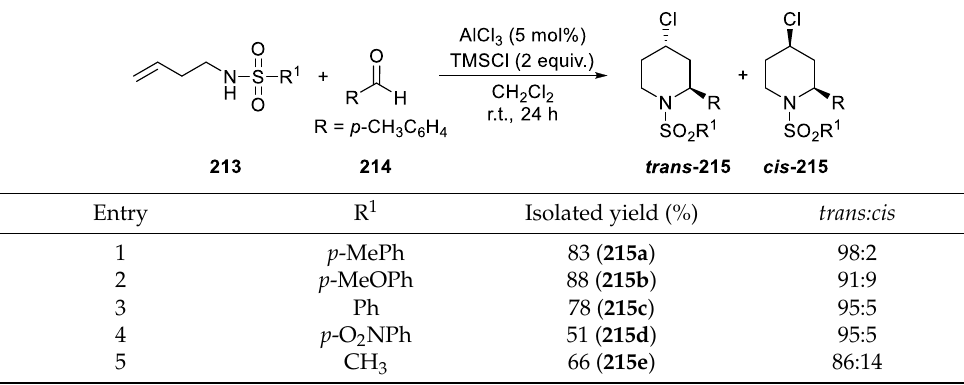
Table 8. AlCl 3 - catalyzed Prins reactions of different aldehydes with N - tosyl homoallylamine.